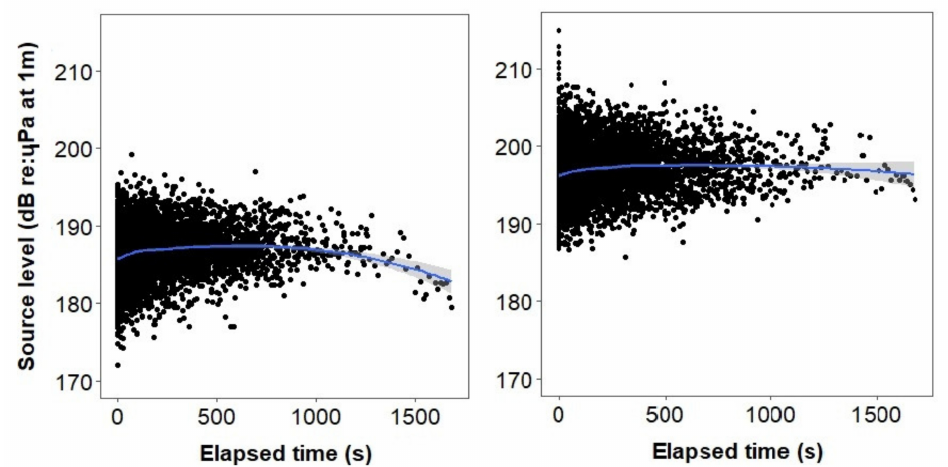
Figure 5. Estimated source levels for 20 Hz fin whale notes detected in the H-channel ( left ) and the Z-channel ( right ) of the OBS off southwest Portugal plotted against the elapsed time within a sequence. A fitted smoothed line (blue) is fitted to the data with its associated 95% confidence intervals in shaded grey. Black dots represent estimated source levels.